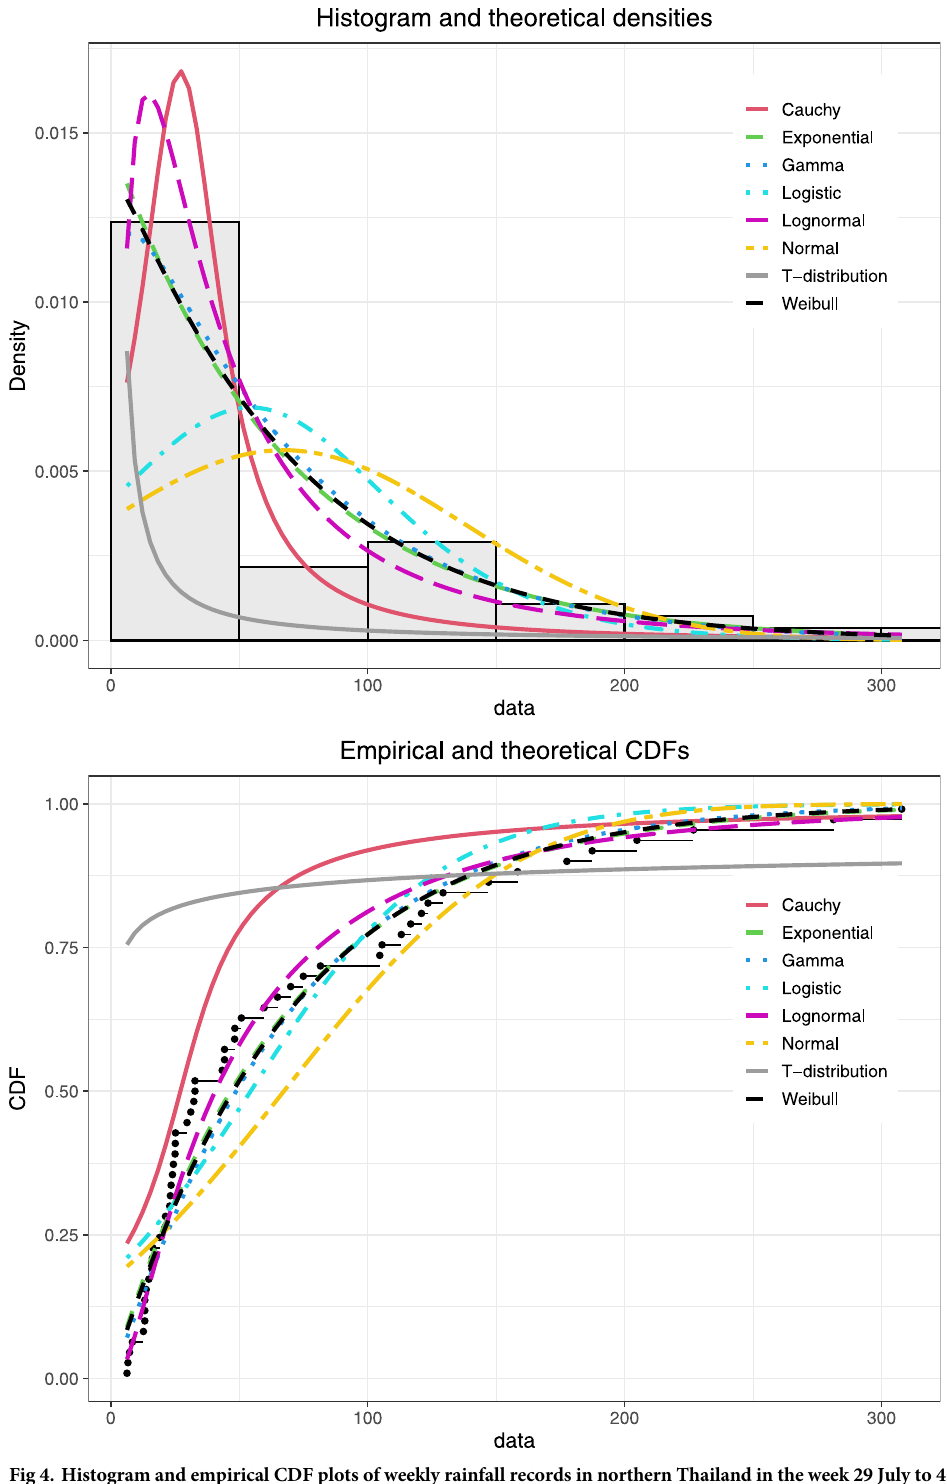
Fig 4. Histogram and empirical CDF plots of weekly rainfall records in northern Thailand in the week 29 July to 4 August 2019.